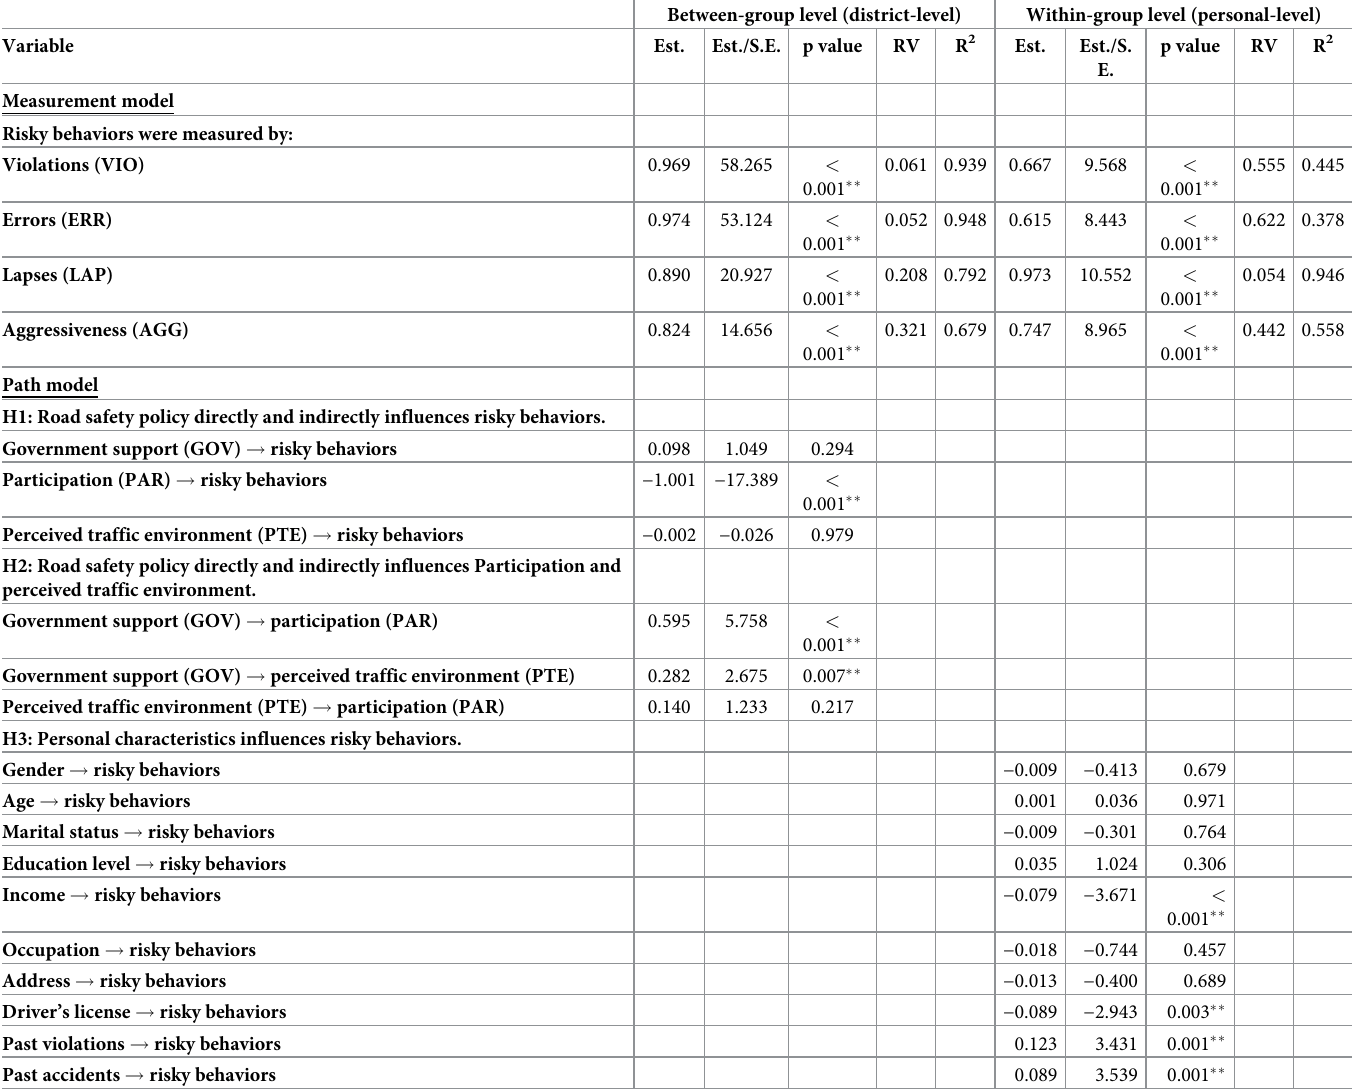
Table 7. Model results for risky behaviors (unsafe